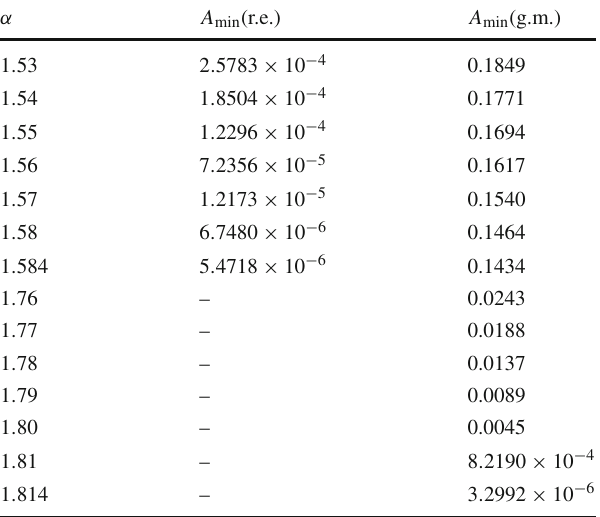
Table 1 Table of A min for selected values of α near α max for radial excitation (r.e.) and gravitating monopole (g.m.) α A min